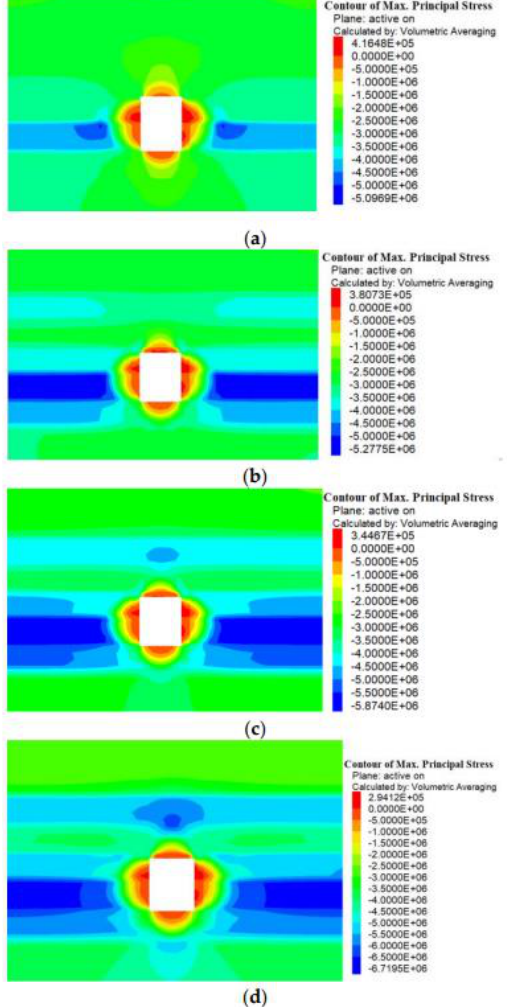
Figure 4. A cloud diagram of the maximum principal stress with different lateral pressure coefficients. ( a ) γ = 0.5; ( b ) γ = 1.0; ( c ) γ = 1.5; and ( d ) γ = 2.0.